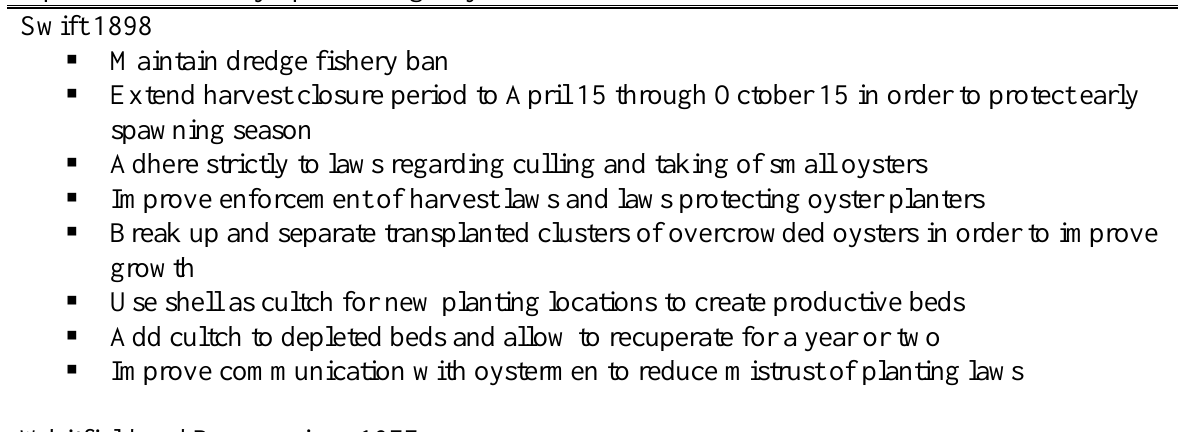
Table A2.4. Apalachicola Bay oyster resource management recommendations compiled from reports from local symposia or agency